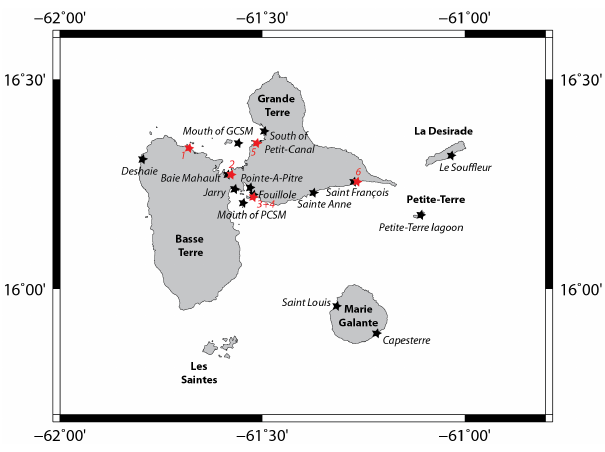
Figure 2. Schematic of Guadeloupe. Geographic location of val- idation (Table 2) and comparison (Table 3) points are indicated by black and red symbols, respectively. (1: Sainte Rose, 2: Baie Mahault, 3: Pointe Fouillole, 4: Pointe-à-Pitre marina, 5: Morne-à- l’Eau, 6: Saint François